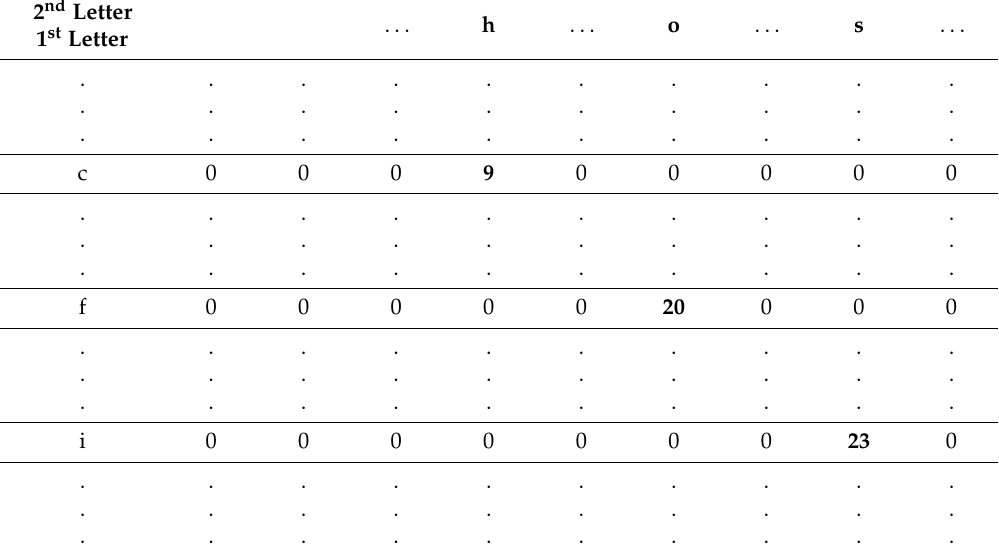
Table 3. Prefix PFAC